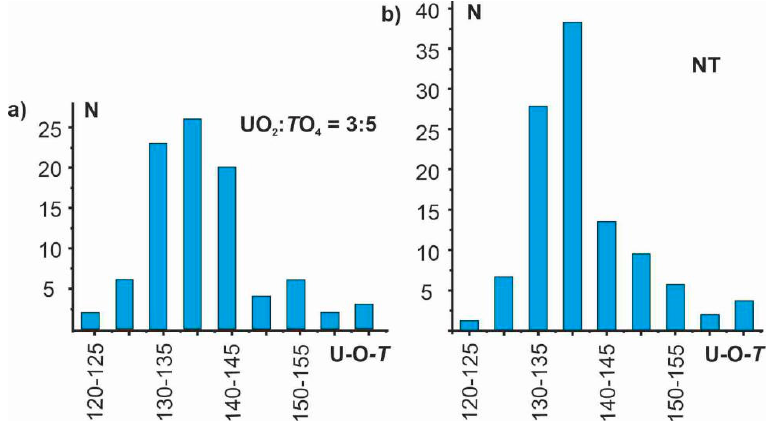
Figure 7. ( a ) The distribution of the U-O- T angles in known UO 2 : T O 4 = 3:5 layers and ( b ) in NT.